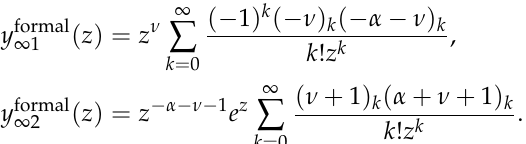
Figure 5. Beyond the optimal order, the approximation of S Borel ∞ ( z ) by the finite sum S m ( z